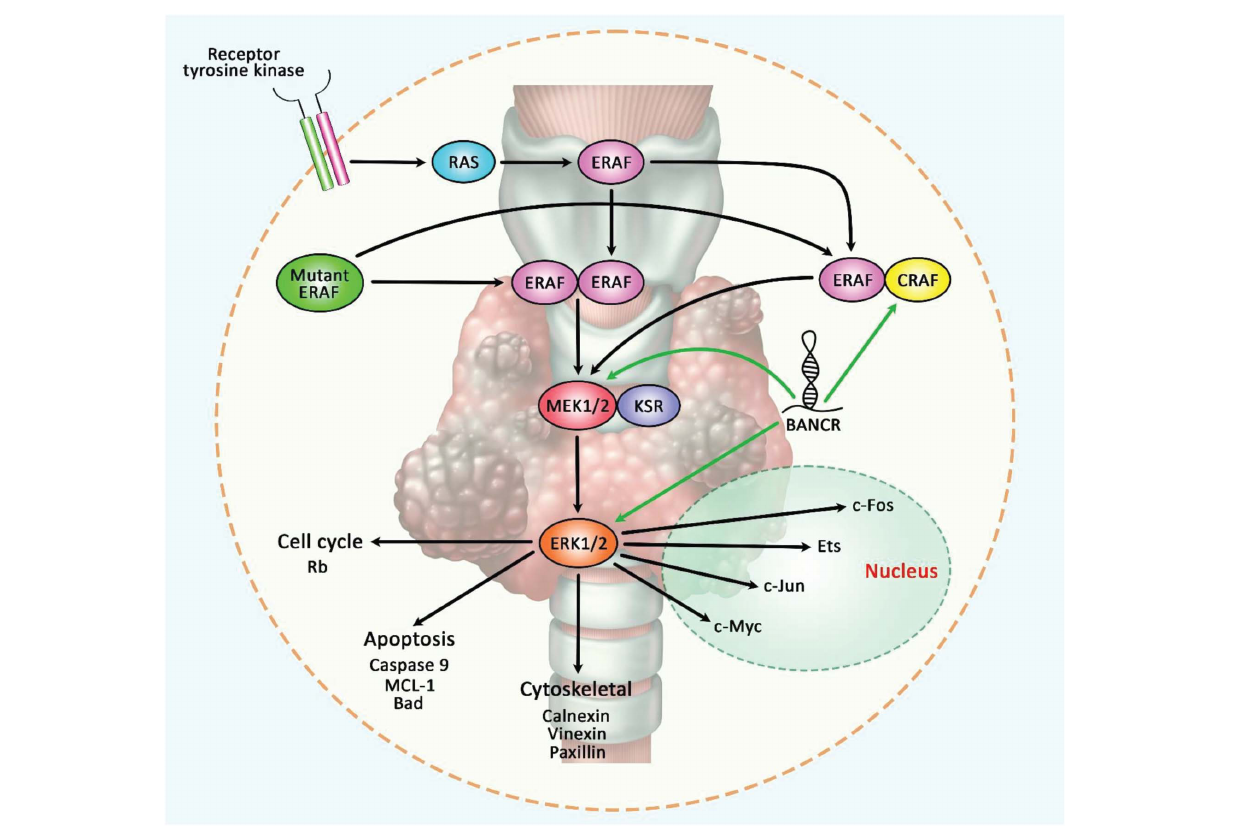
FIGURE 6 | A schematic illustration of the oncogenic role of BANCR in modulating the RAF/MEK/ERK signaling pathway in papillary thyroid carcinoma. The MAPK-signaling cascade is generally triggered via the activation of a receptor tyrosine kinase that could play an important role in activating RAS, which in turn, facilitates homo- or heterodimerization of wild-type BRAF. Activated BRAF could have a potential role in phosphorylating MEK (which is bound to KSR) that could phosphorylate ERK, and thereby leading to various cellular effects including proliferation and survival. Mutant BRAF could trigger dimerization and activation of MEK without Ras activation (Caronia et al., 2011). Growing evidence has demonstrated that lncRNA BANCR could play a crucial role in enhancing epithelial-mesenchymal transition in papillary thyroid carcinoma via up-regulating the expression levels of CRAF, MEK1/2, and ERK1/2 in tumor cells (Wang et al., 2018a,b). Green arrows indicate the up-regulation of target genes modulated via lncRNA